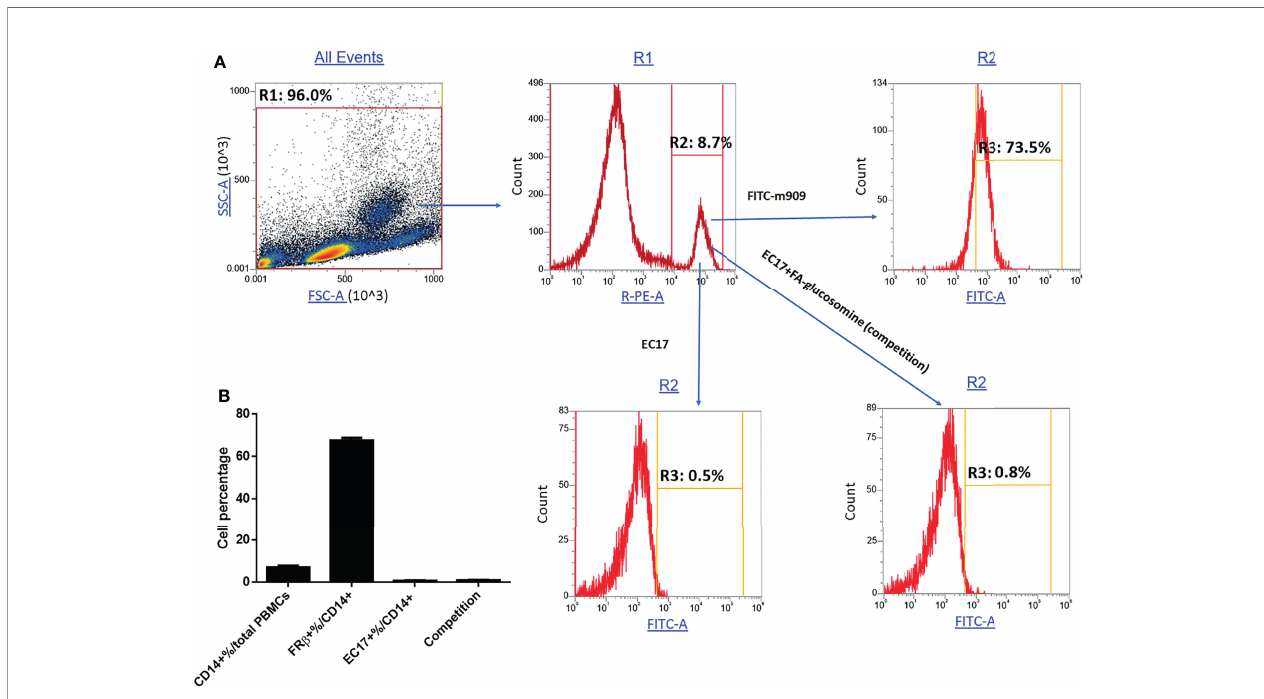
FIGURE 7 | Evaluation of functional and nonfunctional FR b expression in monocytes from fresh human PBMCs. Fresh PBMCs isolated from healthy donors were stained with anti-human PE-CD14, fl uorescein-labeled antibody to human FR b or folate- fl uorescein conjugate (EC17) in the absence or presence of 100X folate-glucosamine (competition) and then subjected to FACS analysis. (A) Representative gating strategy for isolating monocytes (CD14 + %/total PBMCs), total FR b + monocytes (FR b +%/CD14+) and functional FR b (EC17 + %/CD14+). (B) Percentage of monocytes and their functional and nonfunctional FR b expression (n=5 human